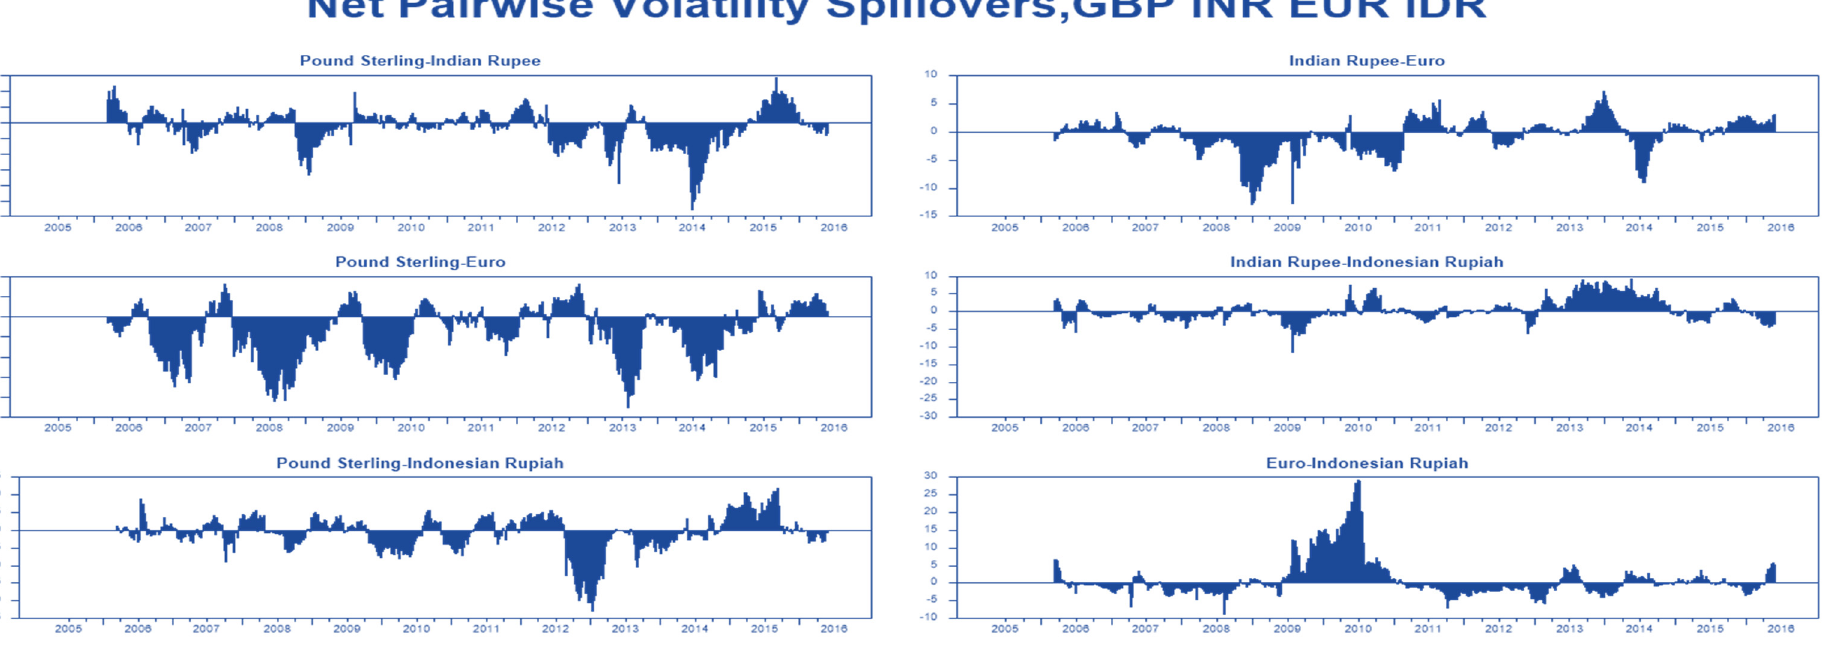
Figure 7. This figure shows the net pairwise volatility spillovers between developed and developing countries. In particular, the net pairwise volatility spillovers from/to the Pound Sterling (GBP), Indian Rupee (INR), Euro (EUR), and the Indonesian Rupiah (IDR).